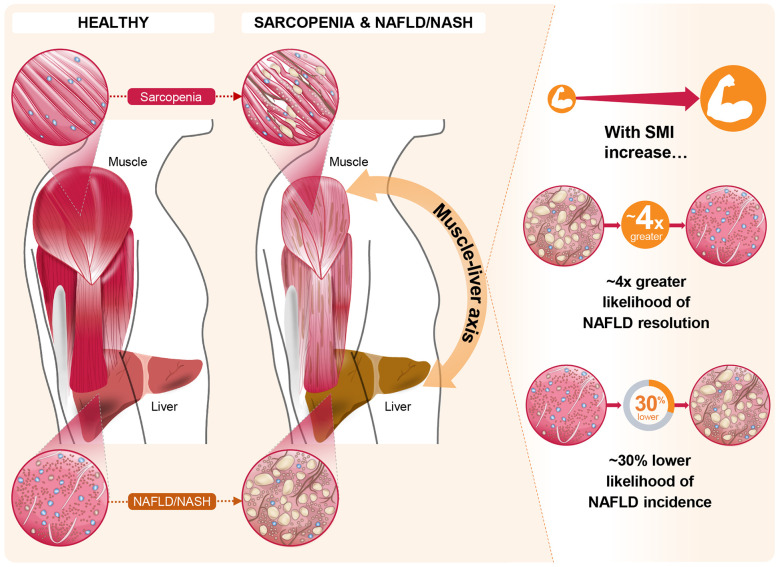
The role of the muscle-liver axis in sarcopenia and non-alcoholic fatty liver disease (NAFLD)/non-alcoholic steatohepatitis (NASH). Recent evidence in the context of NAFLD and NASH, such as that from Kim et al (49). offers compelling associations between changes in skeletal muscle index (SMI) and both NAFLD incidence and resolution of existing NAFLD. In this longitudinal study, these marked associations persisted for the highest tertile of SMI change over 1 year, relative to the lowest tertile, even after full adjustments for multiple covariates including baseline SMI.